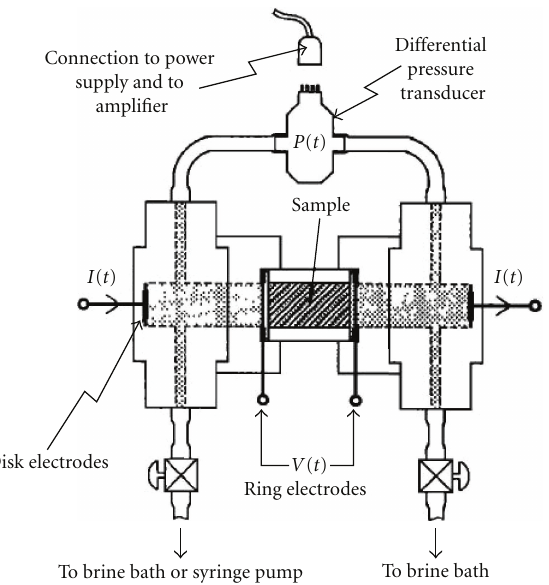
Figure 5: Experimental setup used by Pengra et al. [85] for streaming potential and electro-osmosis measurements (modified from [85]).